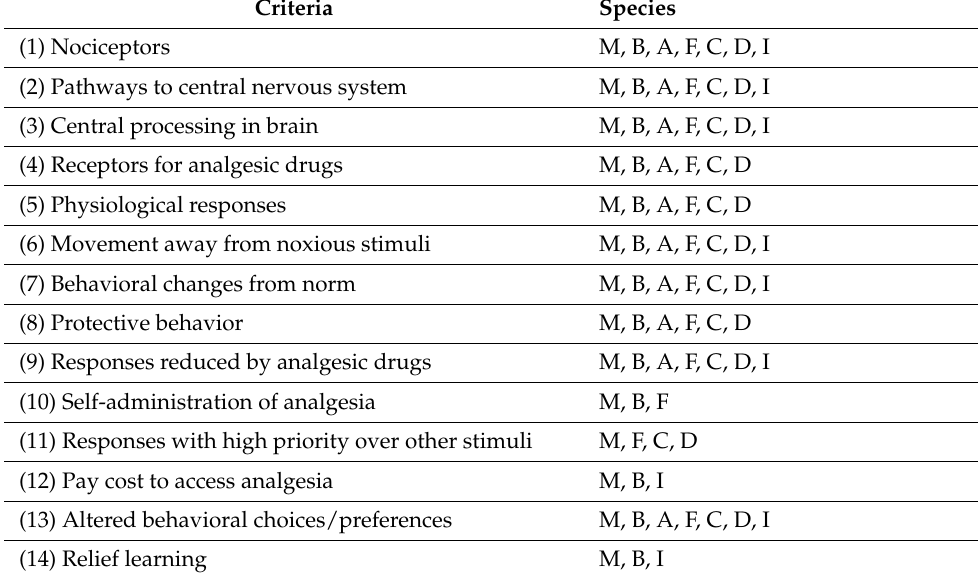
Table 1. Criteria for pain perception